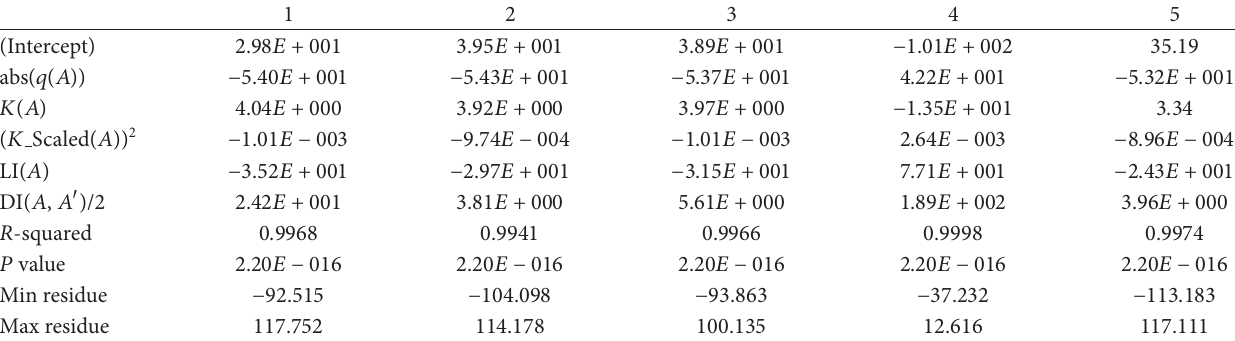
Table 5: The fitted properties of the factors used in the proposed isotropic shielding